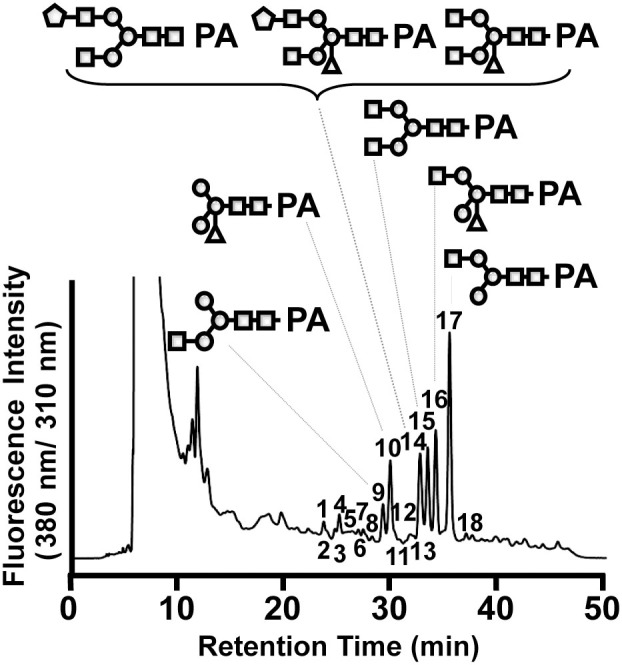
Glycan profile of gCTB.The chromatogram shows RP-HPLC separation of PA-labeled glycans isolated from gCTB. Glycan structures with >2% relative abundance are depicted at corresponding PA-glycan fractions. Symbols: circle (), mannose; square (), N-acetylglucosamine; pentagon (), β1,3-galactose; diamond (), fucose and triangle (), xylose.